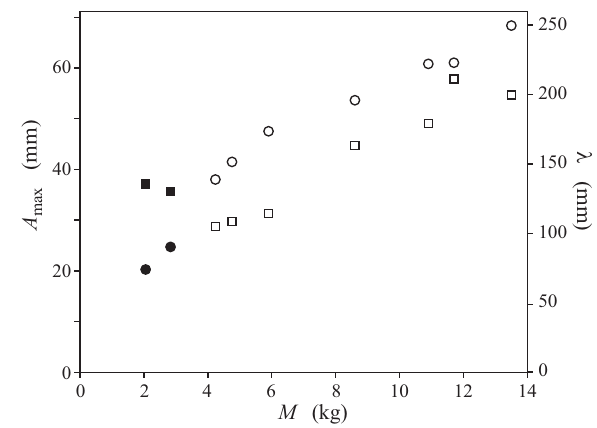
Figure 5. ( ◦ , • ) Maximum amplitude A max and ( (cid:3) , (cid:4) ) mid-height width λ of the leading wave as a function of the mass of the initial column M , for a granular column of aspect ratio a = 2 ± 0 . 2, and of grain diameters d = 5 mm. Empty and filles symbols correspond respectively to breaking and non-breaking waves.